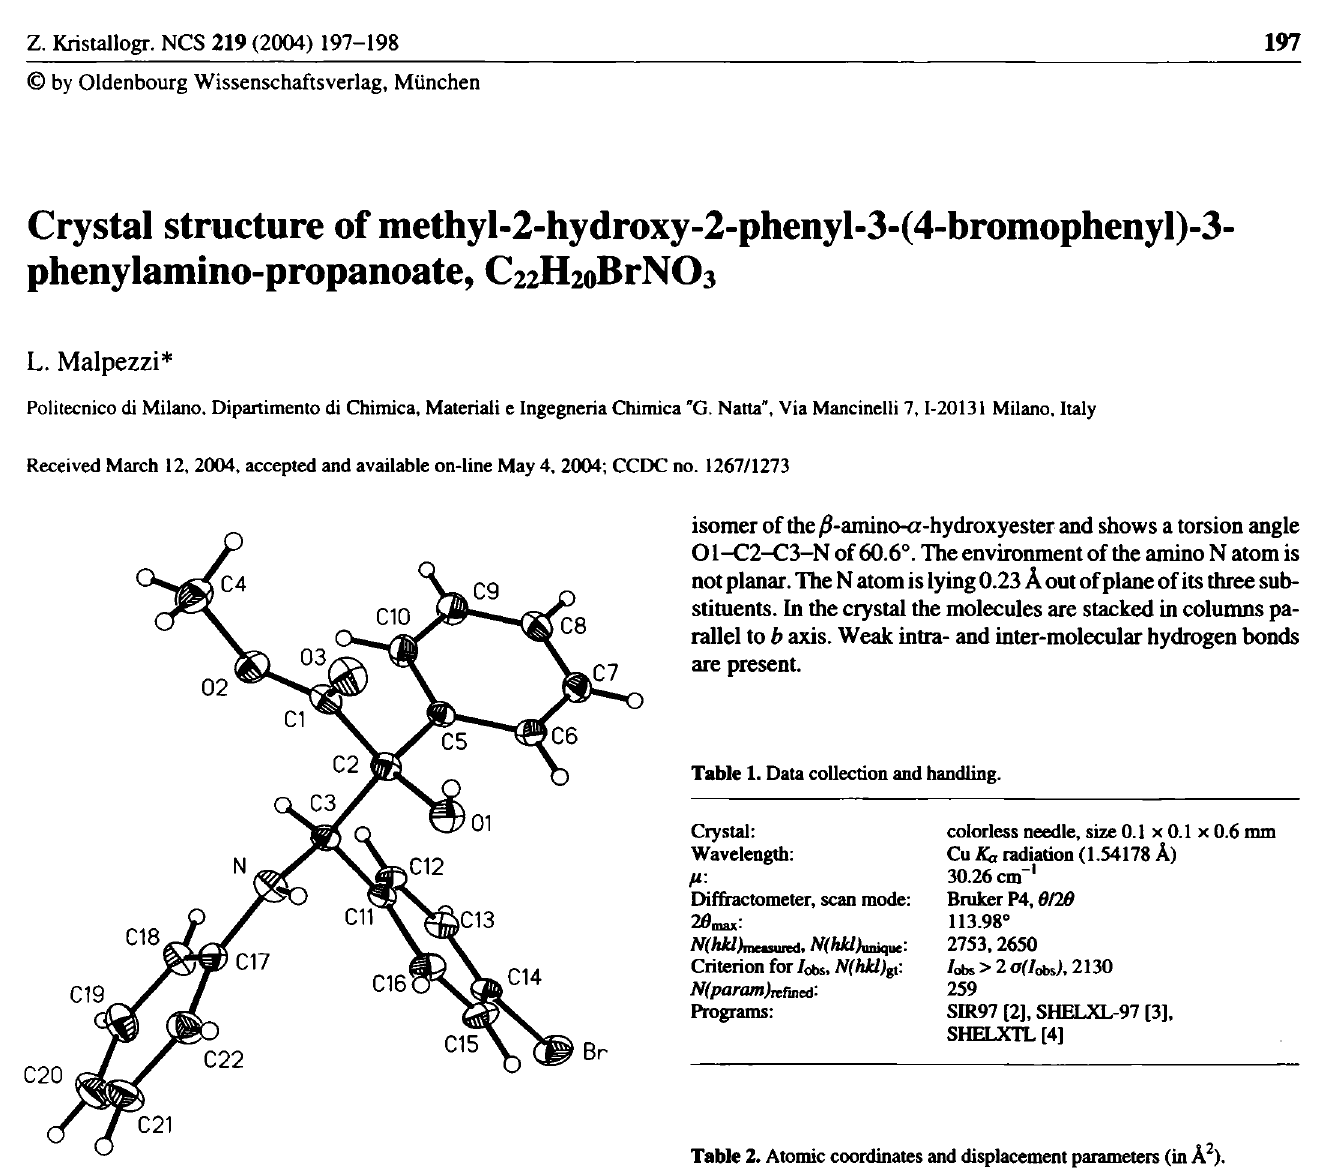
Table 2. Atomic coordinates and displacement parameters (in Â 2